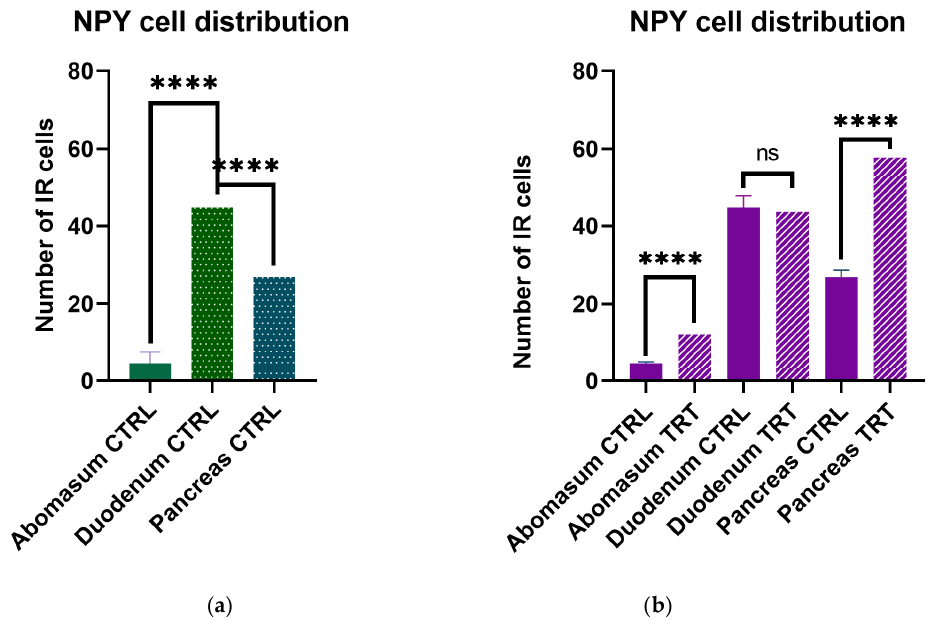
Figure 4. Number of immunoreactive cells in the gastro–entero–pancreatic system of goat kids. ( a ) Higher distribution in the duodenum and pancreas in control animals. ( b ) Statistically increased number of NPY immunoreactive cells in the abomasum and pancreas but not in the duodenum following RLE feed supplementation. **** p > 0.0001; ns non-significant